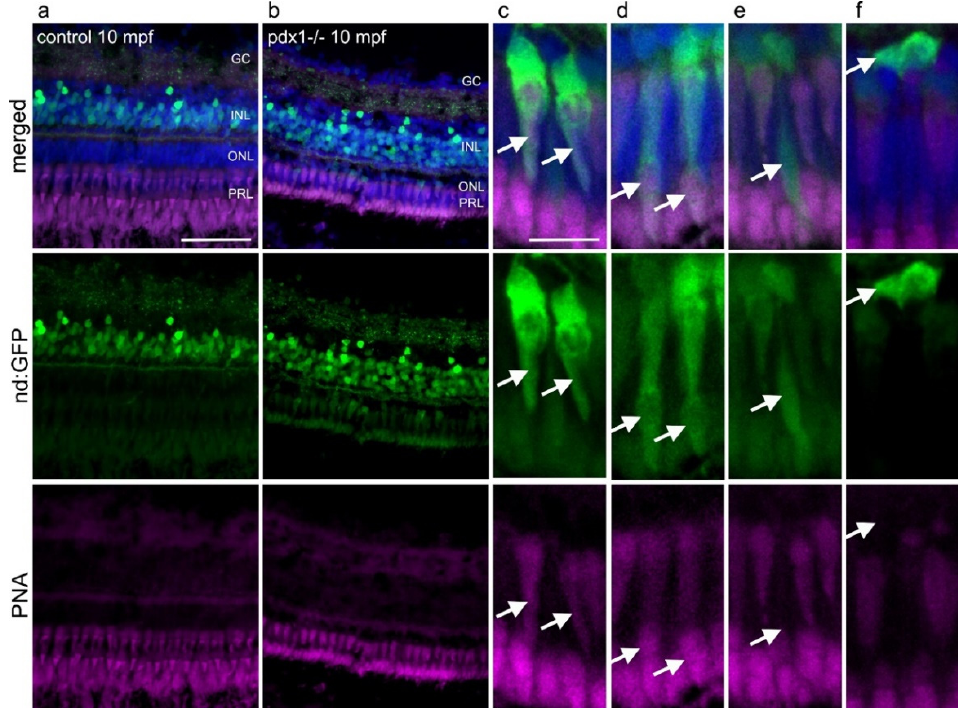
Figure 8. neurod:GFP expressing progenitors give rise to cones and rods in pdx − / − diabetic zebrafish. Expression of GFP in tg(neurod:GFP) in the INL in control fish ( a ) and in the INL and in the ONL in pdx1 − / − fish ( b ). ( c – f ) Higher magnification views of photoreceptors from pdx1 − / − samples as in ( b ). GFP expression overlaps with PNA in cells with cone morphology ( c , d , arrows), while rod ‐ shaped cells ( e , arrow) are PNA negative. Compact cells located basally in the ONL, presumed to be undifferentiated, do not label with PNA ( f , arrow). Sections were counterstained with DAPI (blue). Scale bar: 50 μ m in a and b and 10 μ m in ( c – f ). (INL, inner nuclear layer; ONL, outer nuclear layer; PRL, photoreceptor layer).